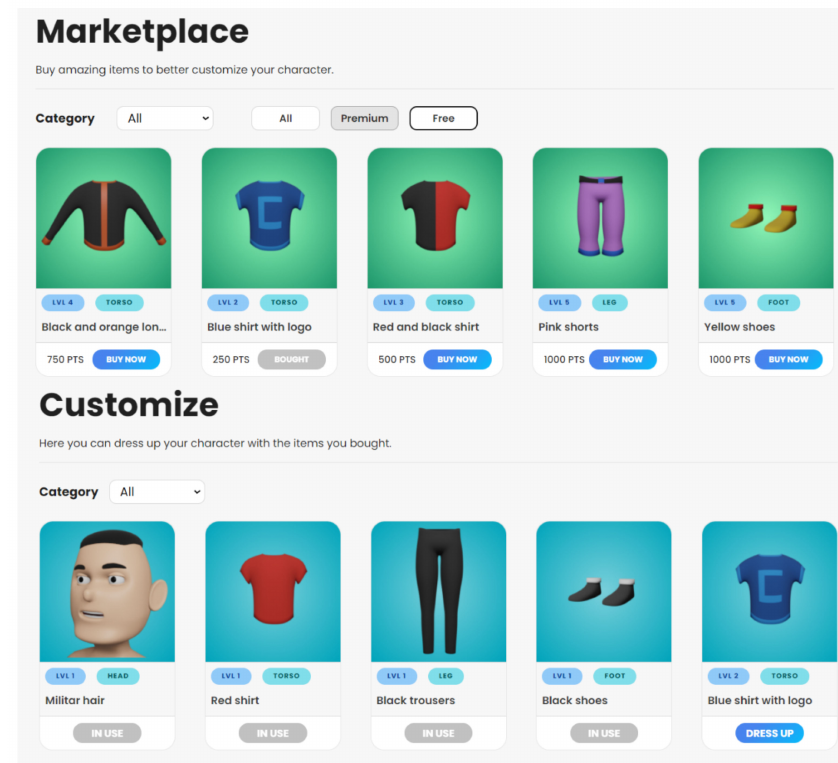
Figure 7. Cognitive assistant marketplace and customization